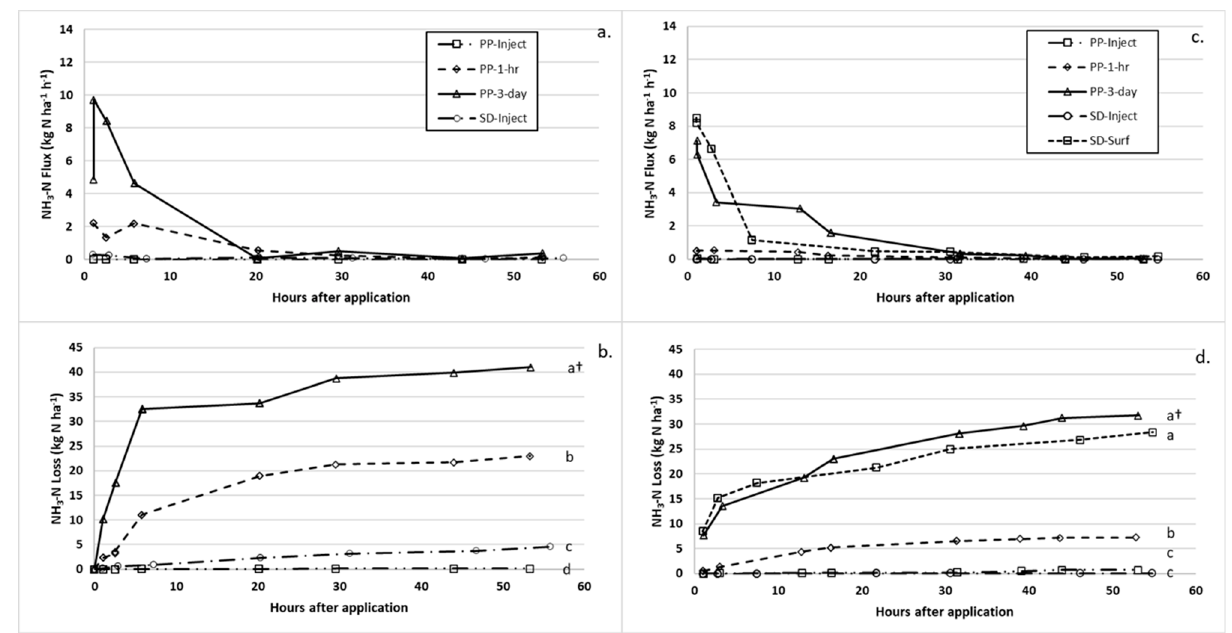
Figure 2. Average ammonia (NH 4 -N) flux values (kg ha − 1 h − 1 ) for ( a ) 2009 and ( c ) 2010 and 2011, and cumulative NH 3 -N (kg ha − 1 ) loss for ( b ) 2009 and ( d ) the average for 2010 and 2011. † Cumulative losses with the same letter are not significantly different at p = 0.01 .